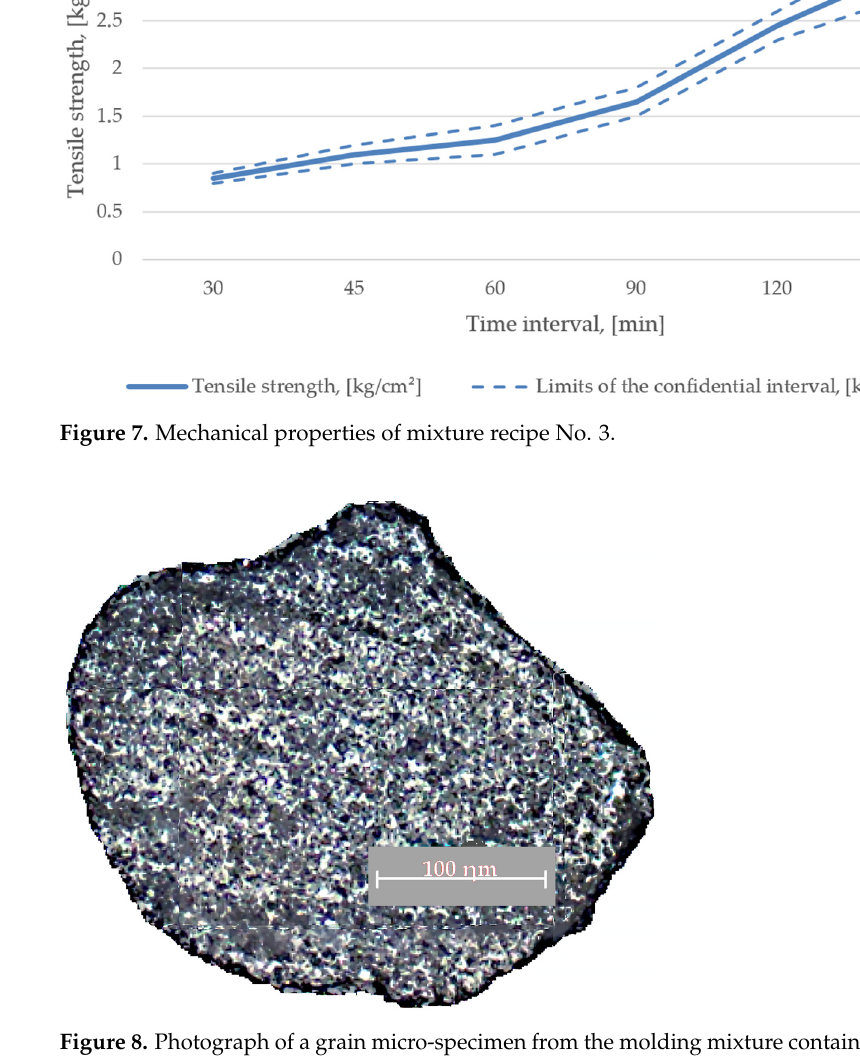
Figure 8. Photograph of a grain micro-specimen from the molding mixture containing the used liq- uid glass mixture, reclaimed product, liquid glass, and hardener.